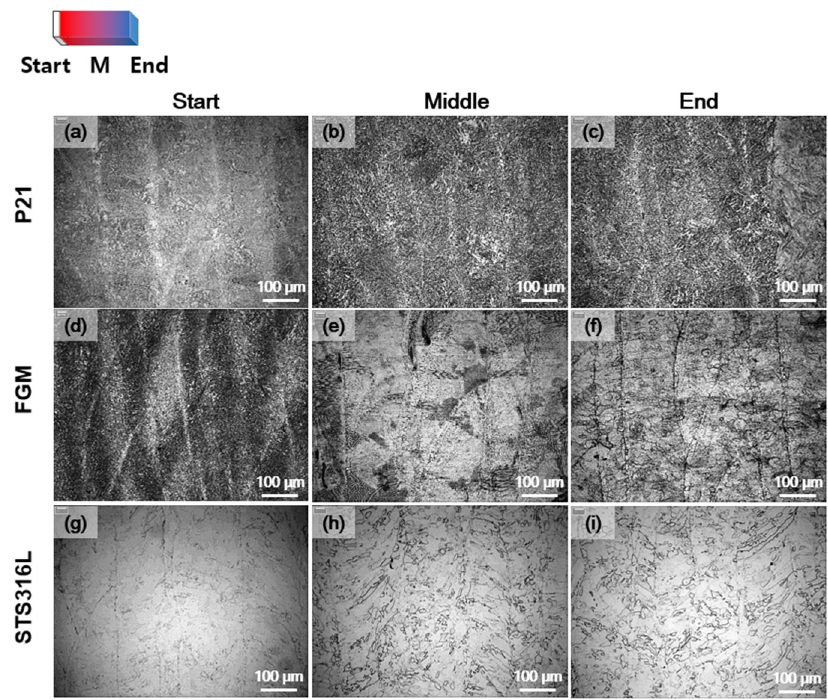
Figure 8. 200× OM microstructure images of P21, FGM and STS316L DED samples: ( a ) P21 start; ( b ) P21 middle; ( c ) P21 end; ( d ) FGM start; ( e ) FGM middle; ( f ) FGM end; ( g ) STS316L start; ( h ) STS316L h; ( i ) STS316L end.